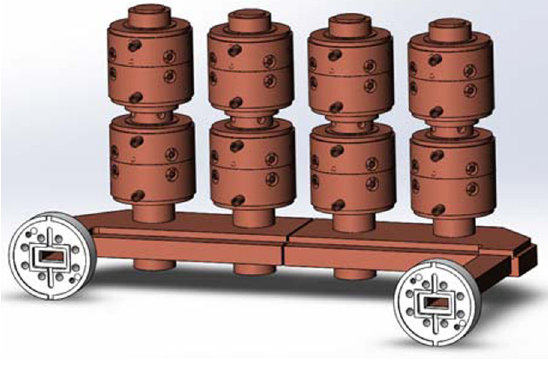
FIG. 13. Assembly of correction cavities and polarizers.